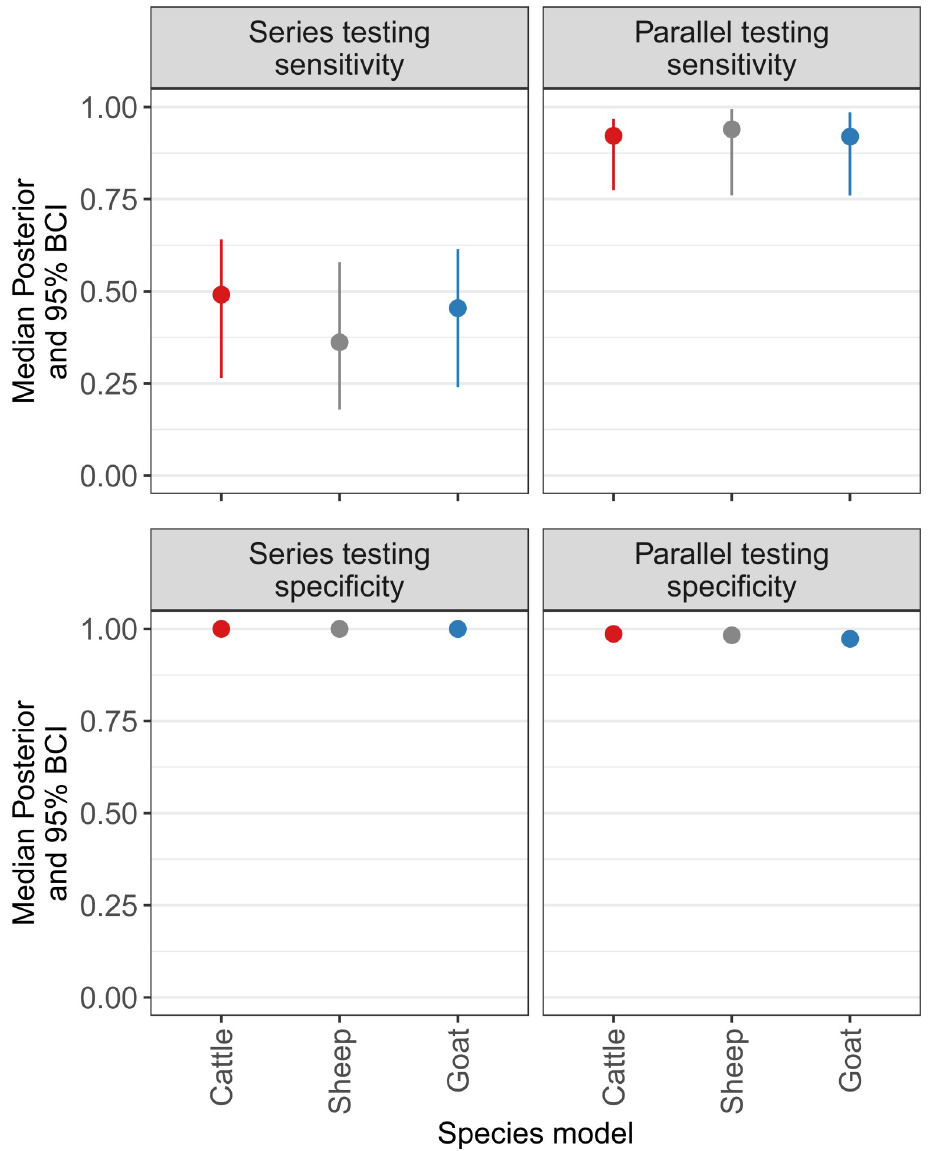
Fig 3. Series and parallel sensitivity and specificity median posterior and 95% BCI estimates for species models. Cattle, sheep, and goat data are from the combined BacZoo study conducted 2013 to 2015 in Arusha and Kilimanjaro Regions, and the SEEDZ study conducted in 2016 in Arusha and Manyara Regions of Tanzania. Series and parallel estimates refer to diagnostic testing using the Rose Bengal plate test (RBT) and the Animal and Plant Health Agency, UK, competitive enzyme-linked immunosorbent assay (cELISA). For sheep and goat models, the modified RBT 3:1 serum to antigen ratio was used. BCI is Bayesian credibility